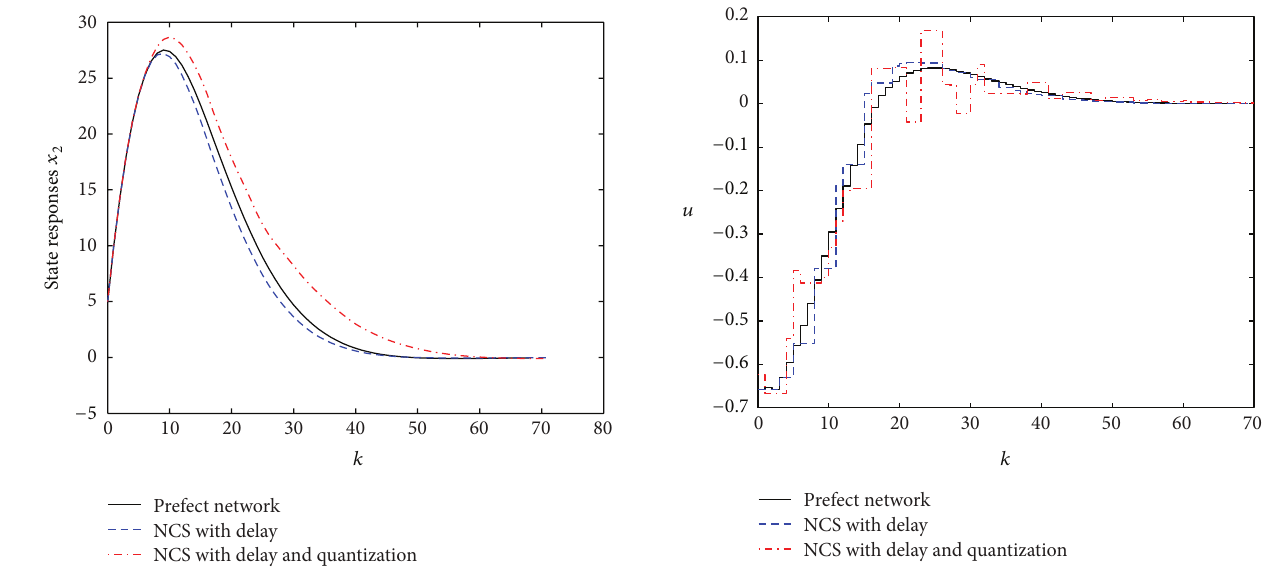
Figure 5: The state responses 𝑥 2 (Example 1).